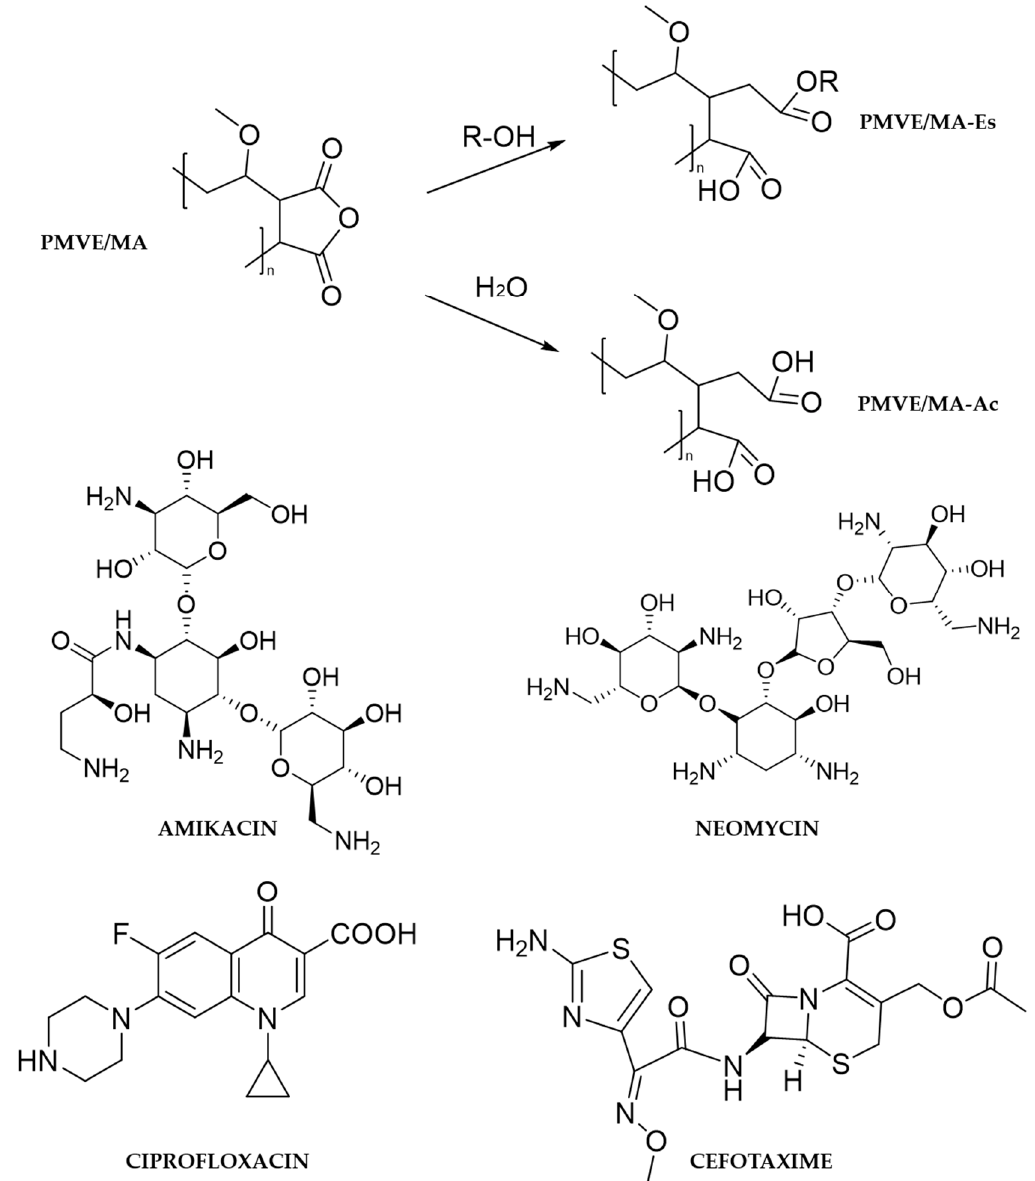
Figure 1. Structures of the principal compounds used. All structures were drawn using ChemBioDraw Ultra v14.0 (CambridgeSoft, Cambridge, MA, USA).